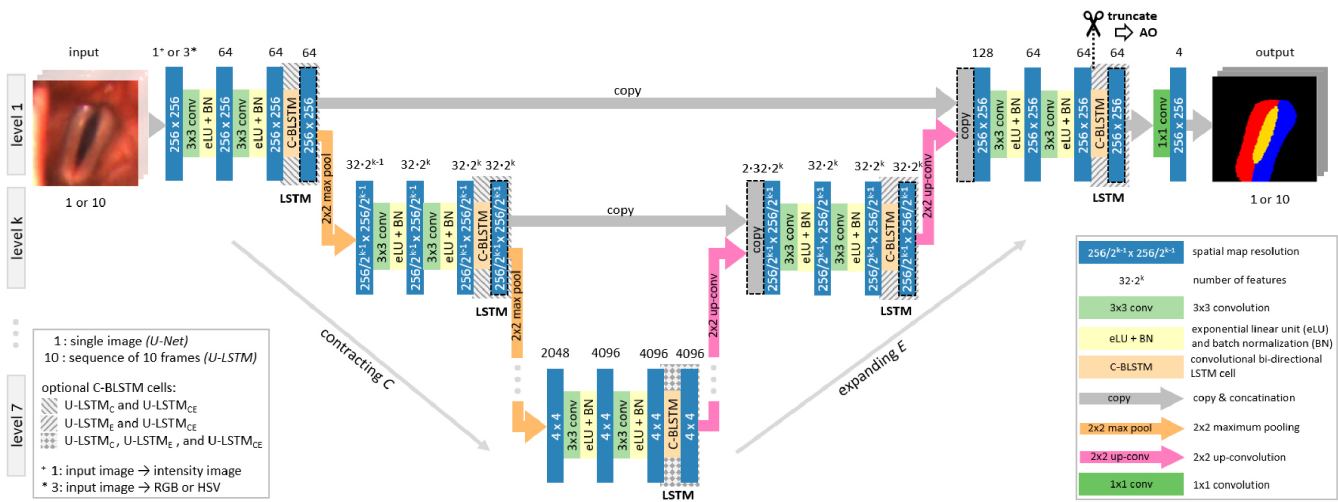
Fig 2. Schematic diagram of the applied Convolutional Neural Network architectures. Individual grayscale, RGB or HSV frames of the high-speed video sequence to be analyzed serve as input. Feature-maps’ spatial dimensions are provided inside the boxes, while the number of extracted feature maps is shown above. During the contracting path the pixel information is downsampled. Extracted features are further propagated to higher levels in the expansive path and concatenated, which is represented by arrows. B-CLSTM cells propagate the temporal information through the network. A 256 × 256 px sized segmentation result is returned, where the value ‘1’ represents the class glottis , while the right and the left vocal fold are indicated by ‘2’ and ‘3’ respectively. The best performing network operates on sequences of ten native RGB video frames as input and has a depth of five levels with C-BLSTM cells in contracting and expanding path.